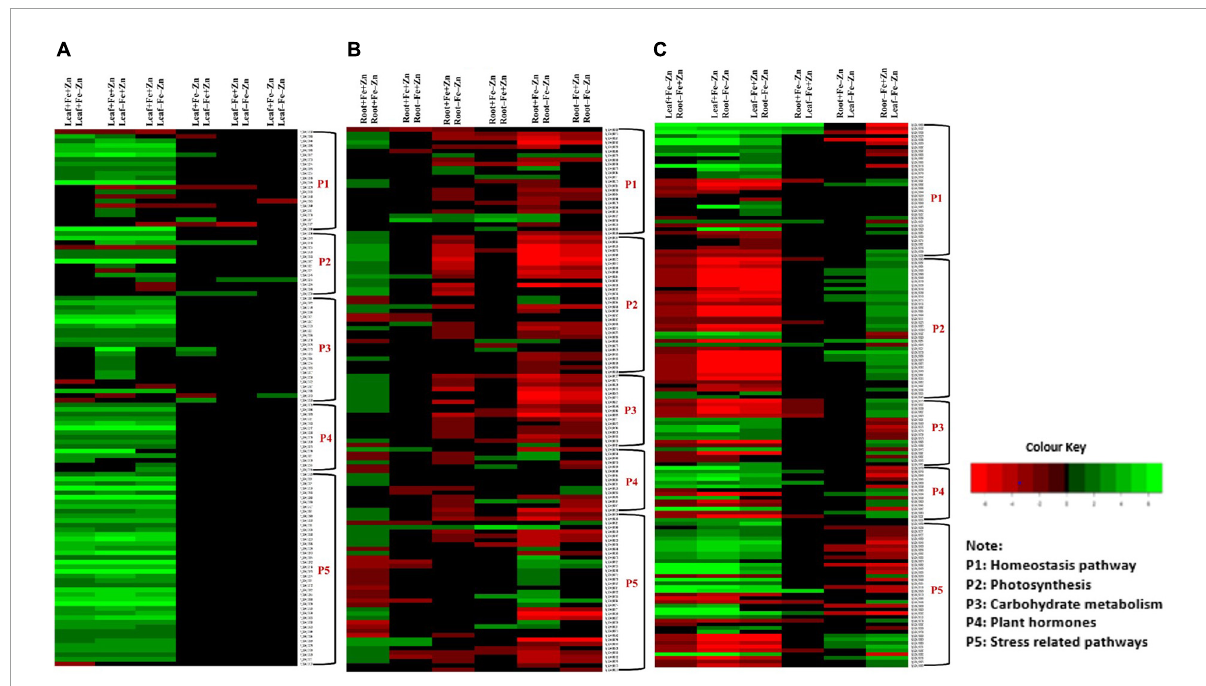
FIGURE2 Heatmap of the selected differentially expressed genes operating under Fe and Zn stress (A) across leaf-pairwise combinations, (B) across root-pairwise combinations, (C) between leaf and root